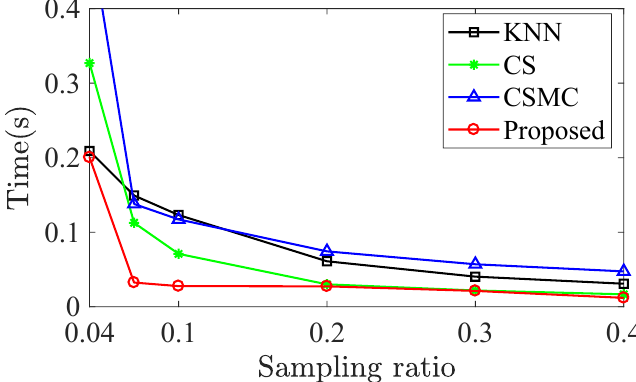
Figure 4. Running time over sampling ratio for temperature data in GreenOrbs.